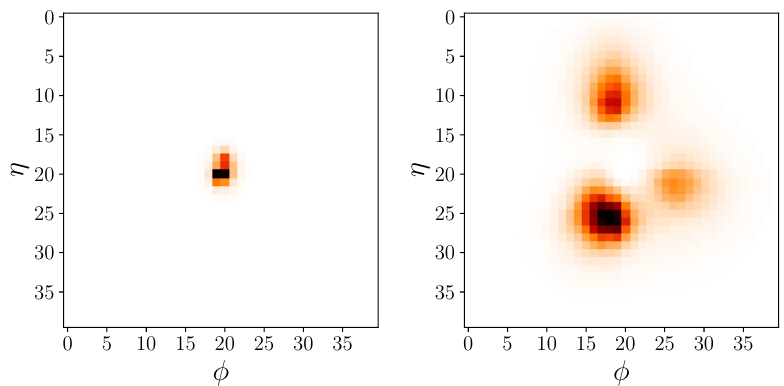
Figure 8: Visualisation of the decoder weights, interpreted as the mixture distribu- = 0 ) (left) and p ( x | r = 1 ) (right) learned by the DVAE tions for p θ ( x | r θ 1 1